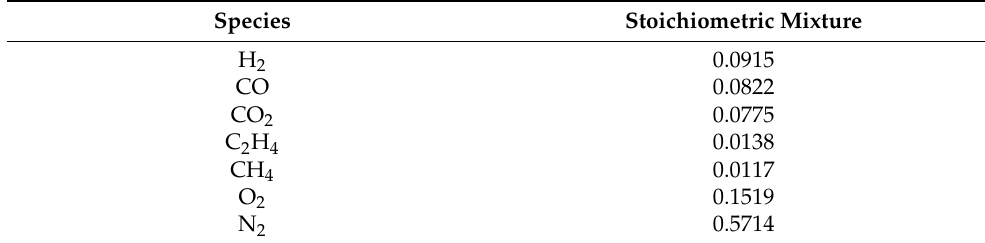
Table 4. Mole fractions of the species before